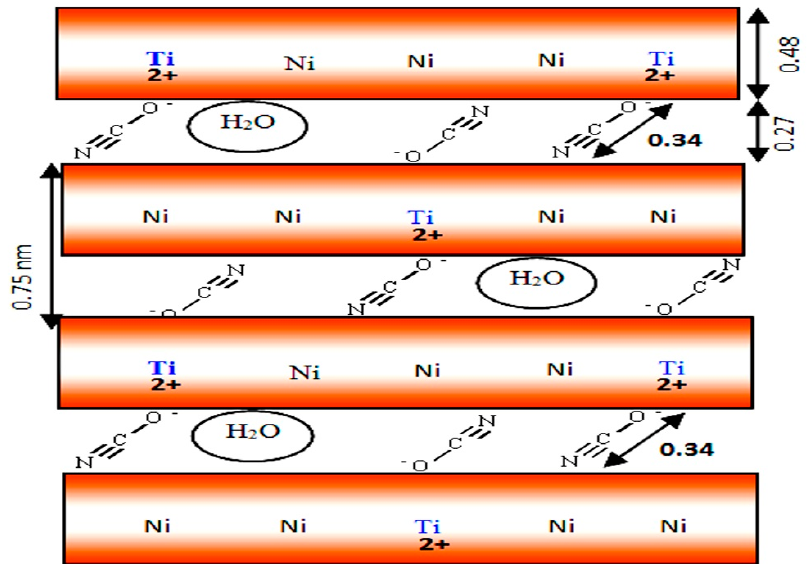
Figure 9. Schematic representation of Ti/Ni LDHs.